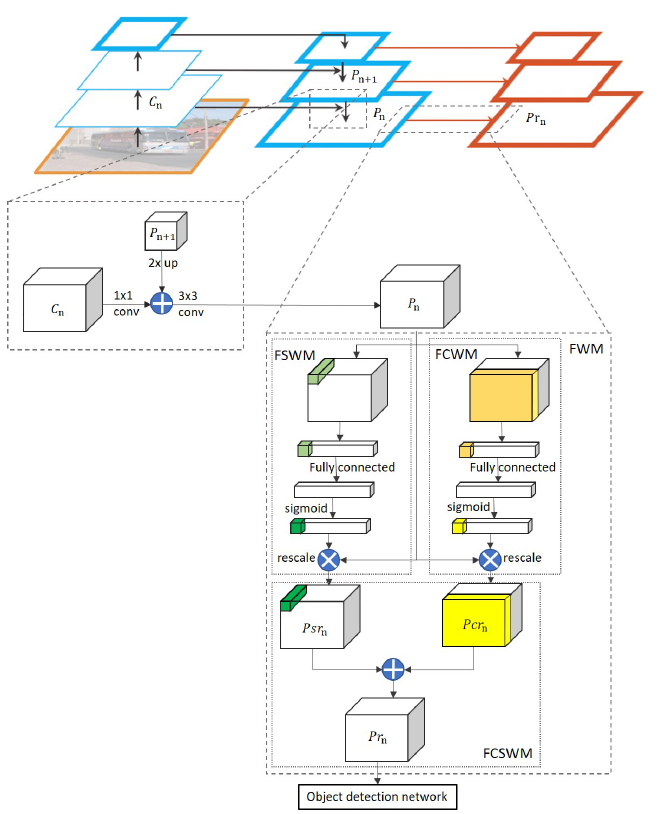
Figure 2. The structure of enhanced feature extraction